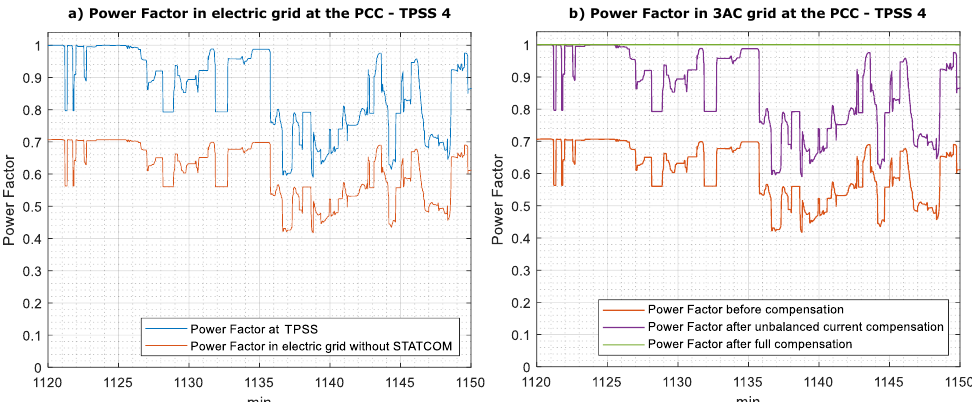
Figure 15. Power factor in the three-phase grid when TPSS 4 is operating in degraded mode: ( a ) without Balancer compensation; ( b ) with Balancer compensation.